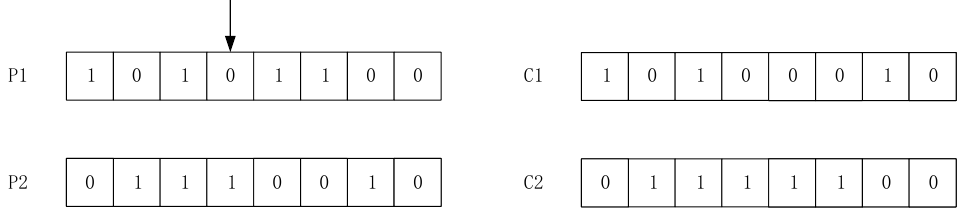
Figure 2. Genetic algorithm single point crossover.